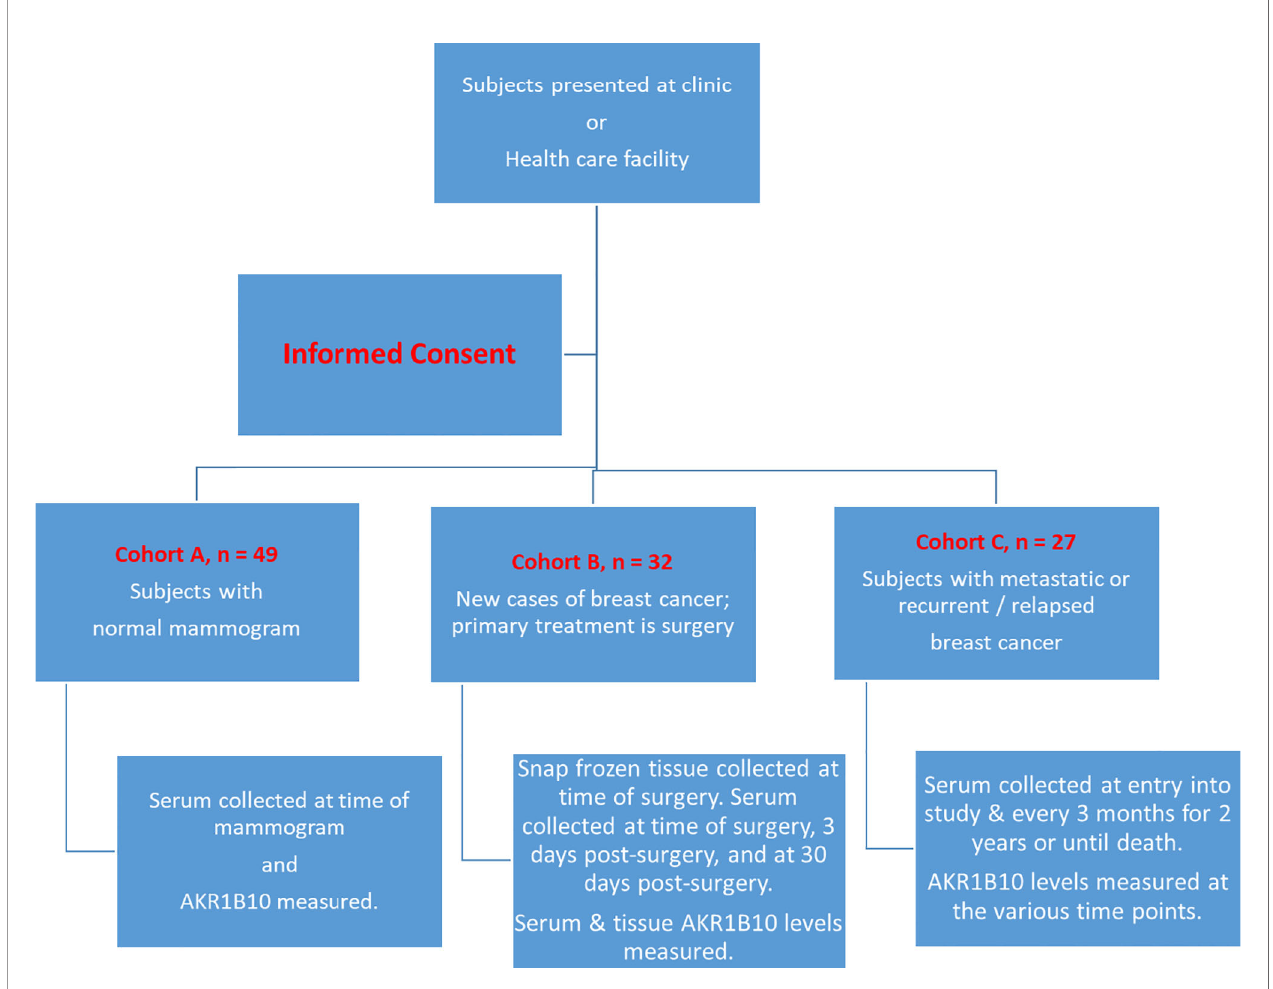
FIGURE 1 | Flow Chart of Schema of the Study. Subjects fi t one of the three cohorts and were then followed and tested as per the protocol